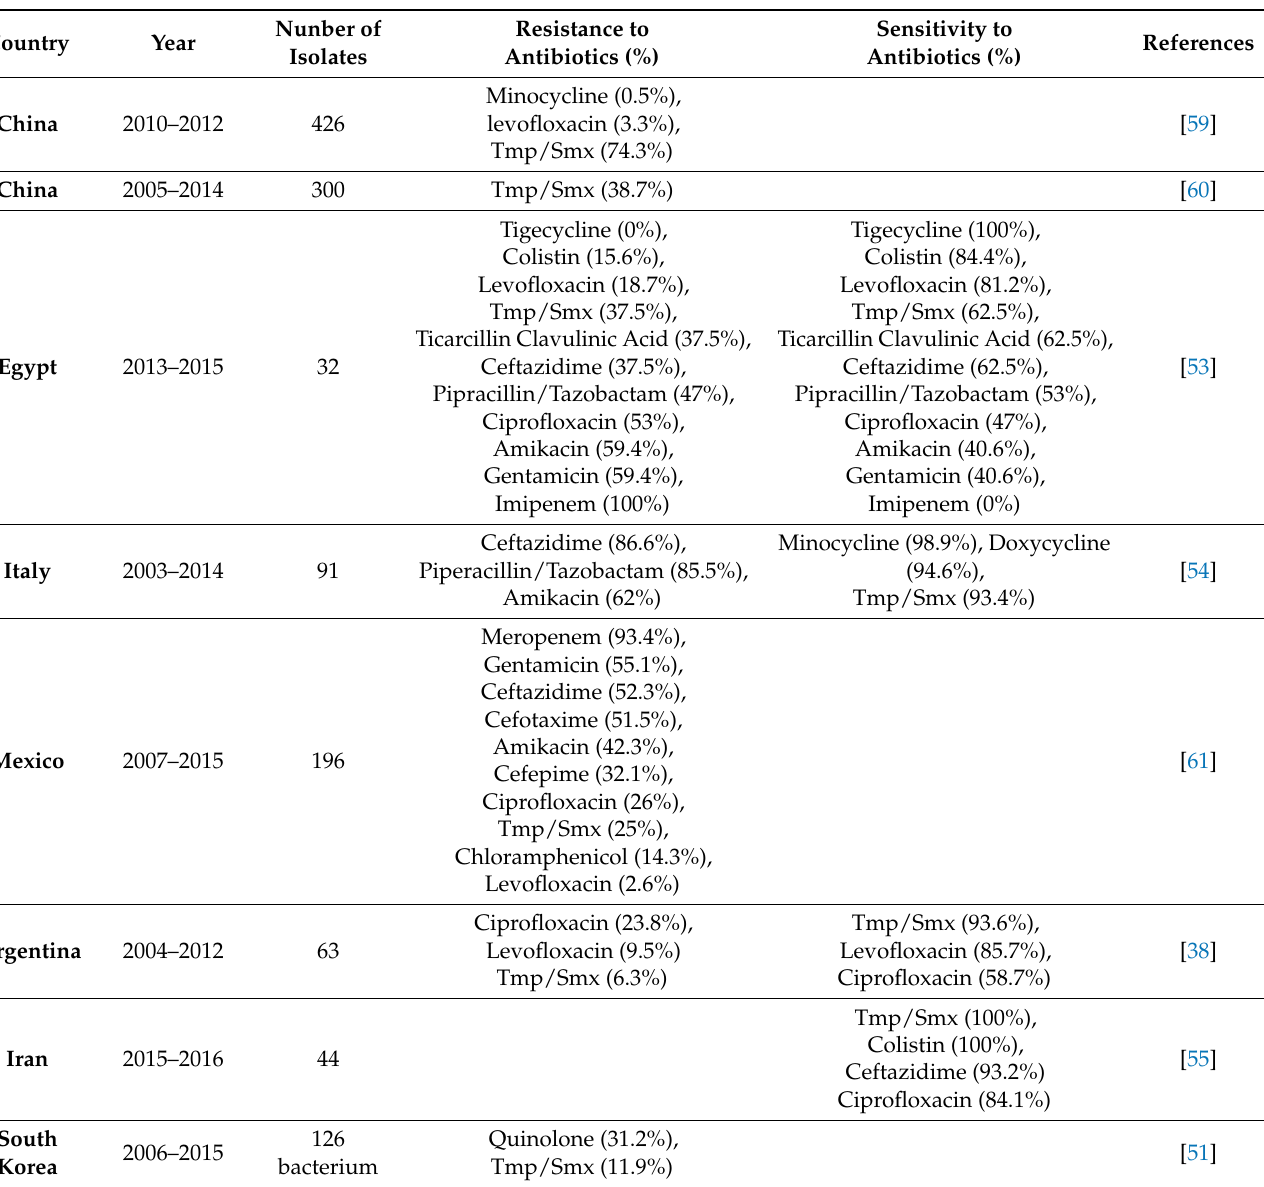
Table 1. Antimicrobial resistance and susceptibility rates of S. maltophilia